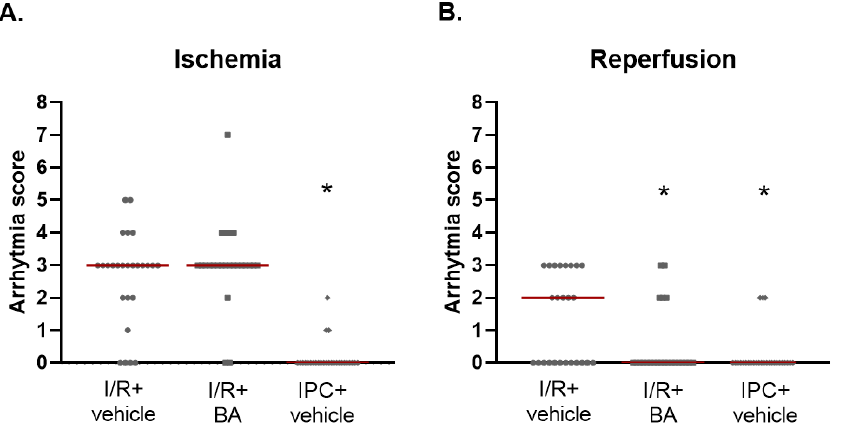
Figure 5. Arrhythmia scores during ischemia ( A ) and the first 15 min of reperfusion ( B ). 28 days of bempedoic acid treatment does not affect arrhythmia score during ischemia but reduces it during reperfusion. Results are presented as median (red line) with individual data points. * p < 0.05 vs. I/R + vehicle group, Kruskal–Wallis test, followed by Dunn’s post hoc test, n = 23–27/group. BA: bempedoic acid. IPC: ischemic preconditioning. I/R: ischemia/reperfusion.